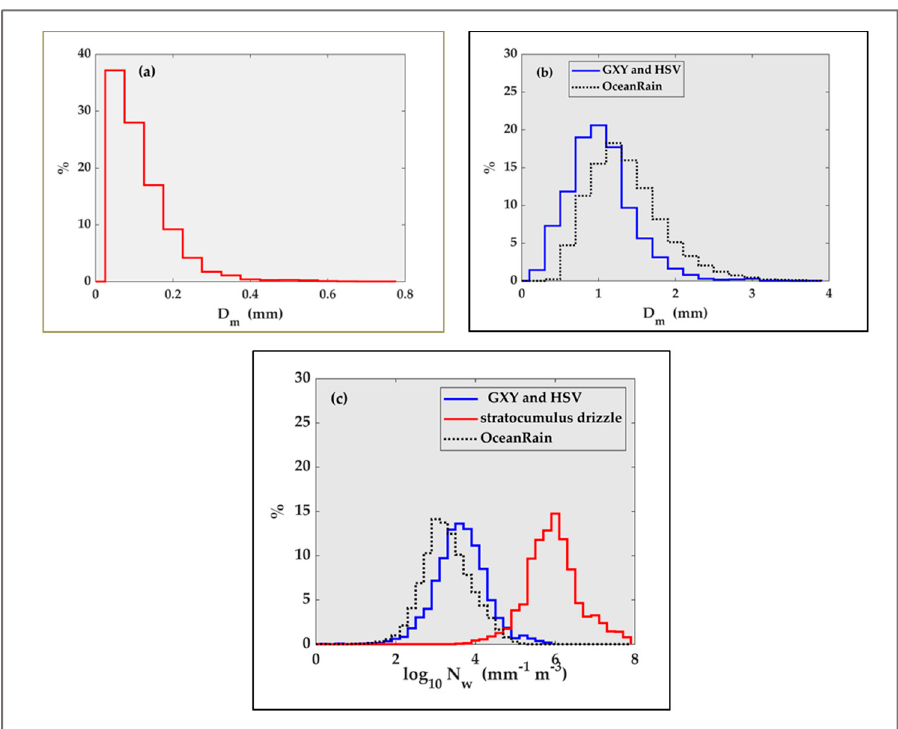
Figure 3. Relative frequency histograms of ( a ) D m from stratocumulus drizzle, ( b ) same as ( a ) but from OceanRain and pooled DSDs from GXY-HSV, and ( c ) histograms of log 10 (N W ) from OceanRain and pooled DSDs and from stratocumulus drizzle (red line).